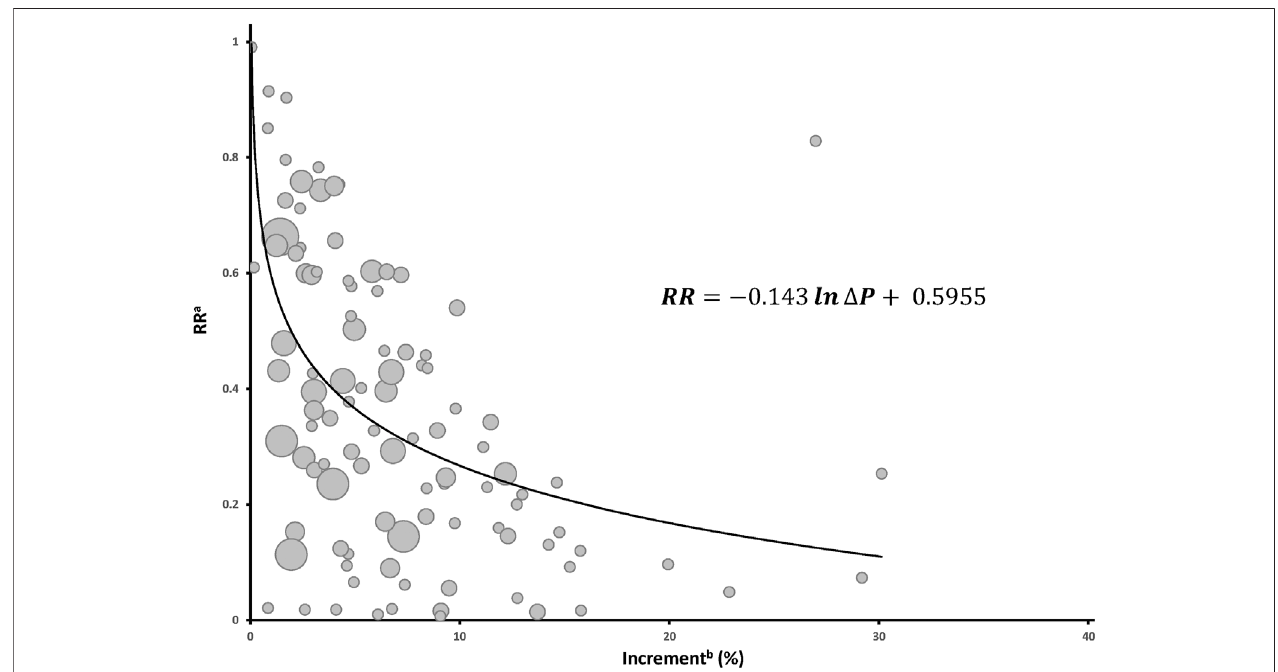
FIGURE5| Logarithmic fi ttingdiagramoftheincreaseinlatrinecoverageandrelativerisk(RR)value.Note:thesizeofthebubblesrepresentsthenumberofstudies pooled. a RR.Thisvaluecontainstheeffectsizeoftheoriginalstudyandthepooledeffectsizeofseveralstudies(forsimilarstudieswithanumberlessthan3,effectvalues were not pooled). b Increase represents the annual coverage increase. In the function, Δ P was the annual coverage increase, which refers to the growth of latrine coverage in a year for an included study; RR was the relative risk of annual incidence.